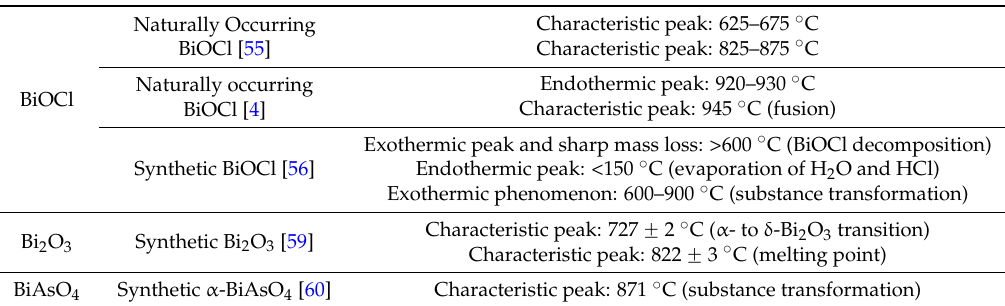
Table 7. Summary of thermal data on BiOCl, Bi 2 O 3 and BiAsO 4